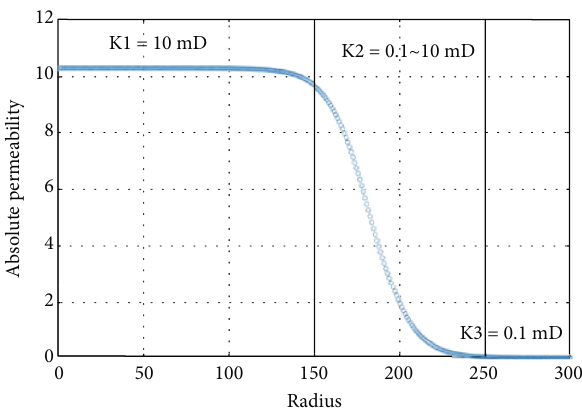
Figure 3: Permeability of the fl ow fi eld around a fractured horizontal well in tight